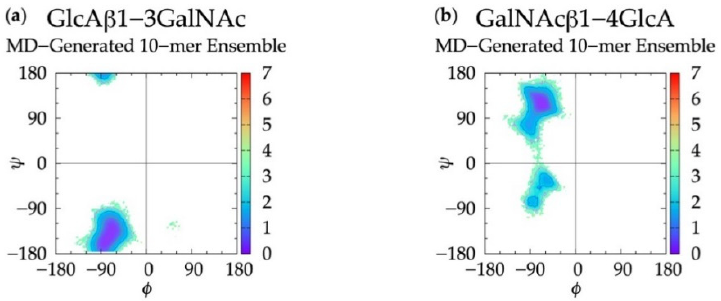
Figure 9.  G (  ,  ) plots for each glycosidic linkage in non ‐ sulfated chondroitin 10 ‐ mer MD ‐ Figure 9. ∆ G ( φ , ψ ) plots for each glycosidic linkage in non-sulfated chondroitin 10-mer MD-generated generated ensembles: ( a ) GlcA β 1 ‐ 3GalNAc and ( b ) GalNAc β 1 ‐ 4GlcA. ensembles: ( a ) GlcA β 1-3GalNAc and ( b ) GalNAc β